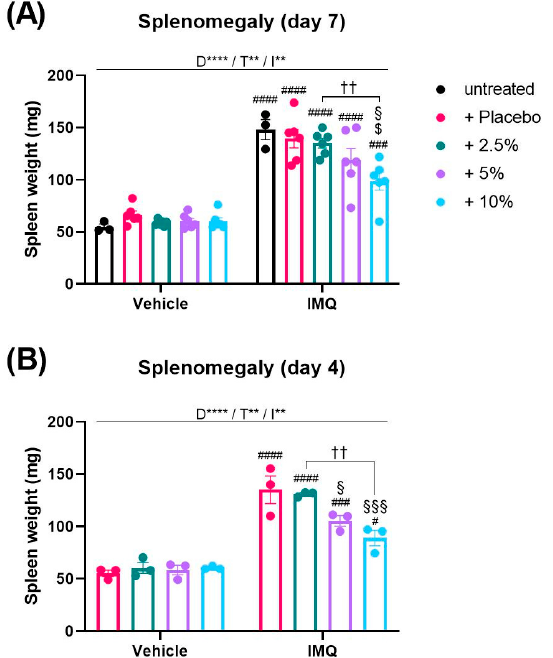
Figure 2. Diacerein reduces IMQ-induced splenomegaly. Spleen weight in mice on day 7 ( A ) after receiving treatment for 6 consecutive days, and on day 4 ( B ) after receiving treatment for 3 consecutive days. Psoriasis was induced by daily topical application of 62.5 mg Aldara ® (IMQ) to the dorsal skin. Following IMQ, mice were treated with 100 mg of 2.5%, 5%, or 10% diacerein or placebo or the skin was left untreated. Control mice received vehicle cream. Data represent means ± SEM. n = 3–6 per group. Two independent experiments ( A )., ** p < 0.01, **** p < 0.0001, two-way ANOVA main effects (D = Disease; T = Treatment; I = Interaction). Sidak’s multiple comparisons test: †† p < 0.01; # p < 0.05, ### p < 0.01, #### p < 0.0001 vs. respective vehicle group; § p < 0.05, §§§ p < 0.001 vs. IMQ +